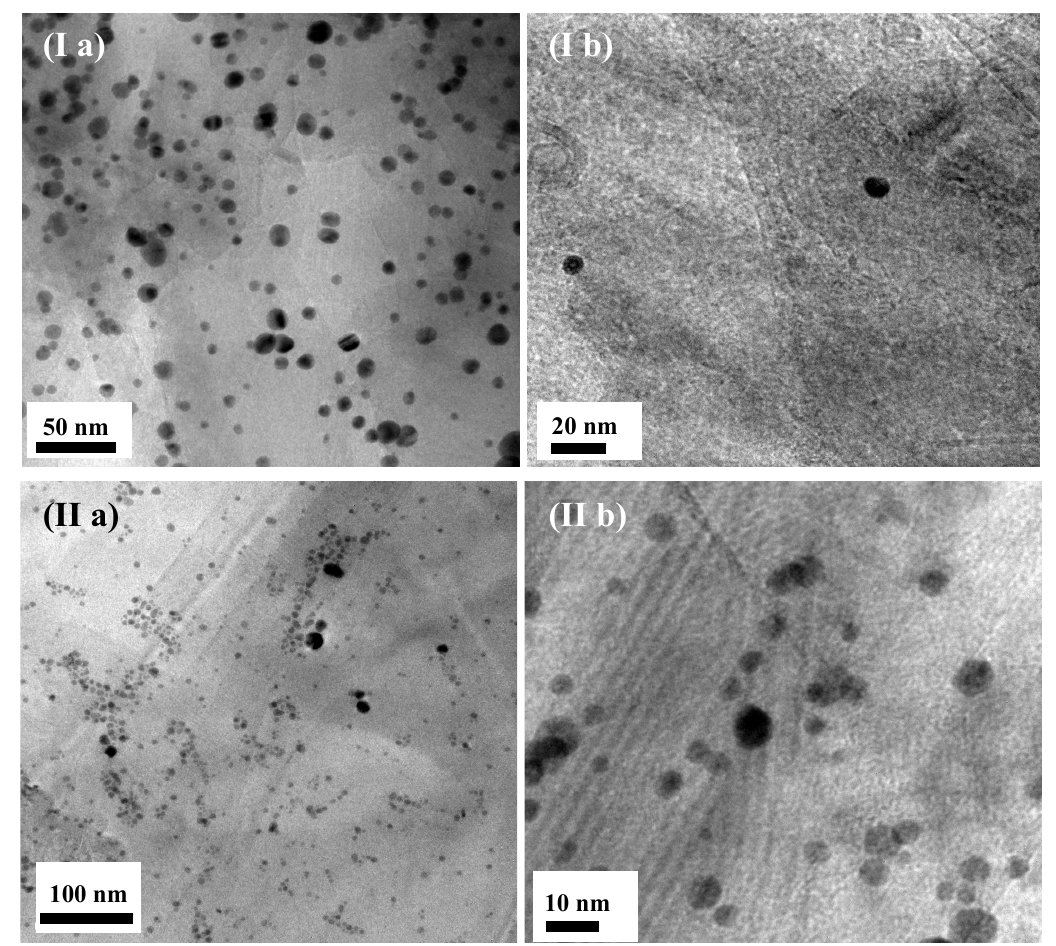
Figure 7. Representative ( a ) low and ( b ) high magnification TEM micrographs associated to the reduced samples ( I ) Au/G-IMP and ( II )